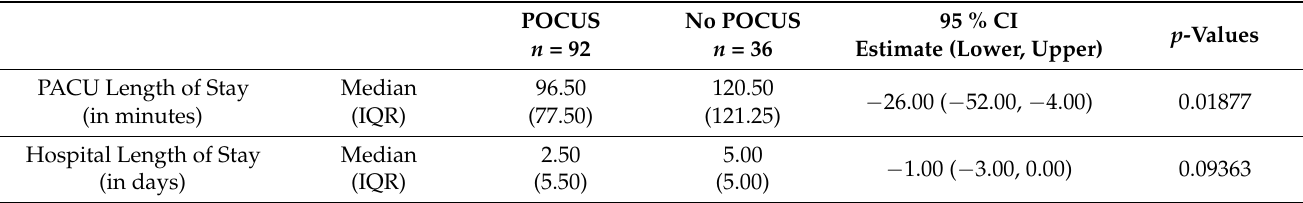
Table 2. Post-surgery outcome comparisons between hypoxic/hypotensive patients; group indicator for subjects with point-of-care ultrasound or without.